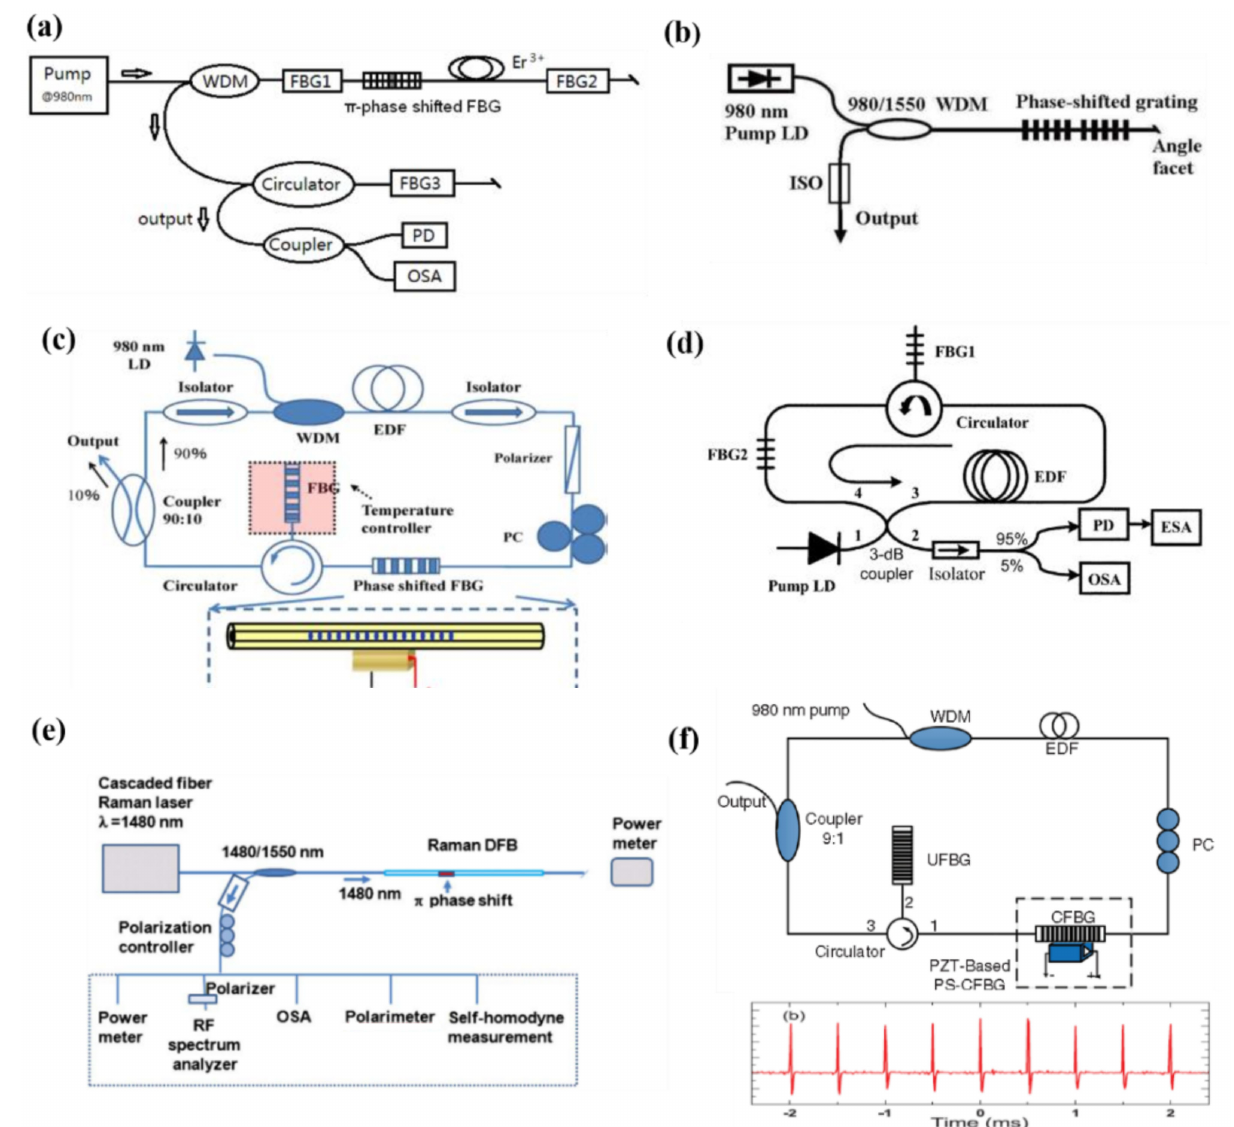
Figure 5. ( a ) Schematic diagram of a DFB fiber laser [42]. ( b ) Schematic diagram of an SLM DBR fiber laser [46]. ( c ) Schematic diagram of PZI-induced PS-FBG-based EDF ring laser. Adapted with permission from ref. [31]. ( d ) Equivalent PS-FBG-based EDF ring laser. Adapted with permission from ref. [51]. ( e ) Raman DFBs laser [53]. ( f ) Q-switched EDF ring laser